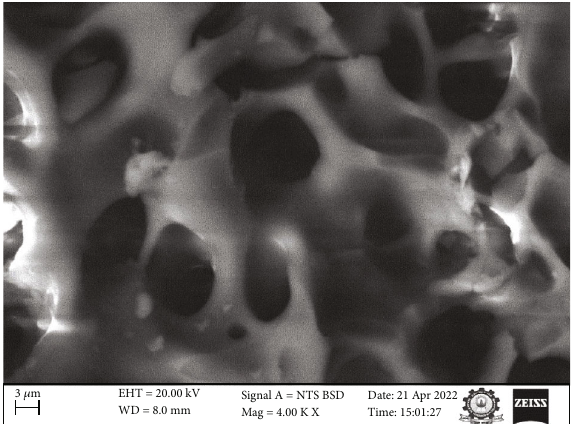
Figure 1: SEM image of CTASP before adsorption of dye.